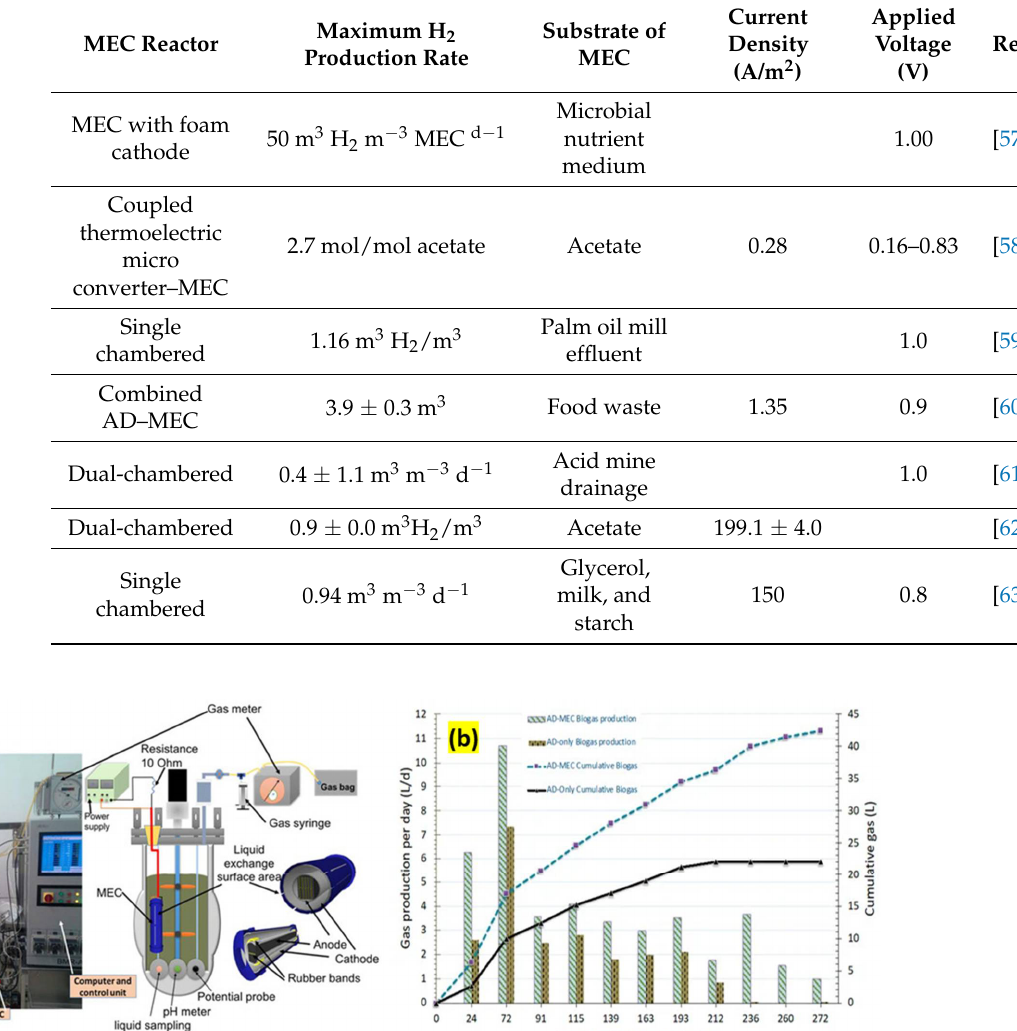
Table 2. Modifications of MECs for hydrogen